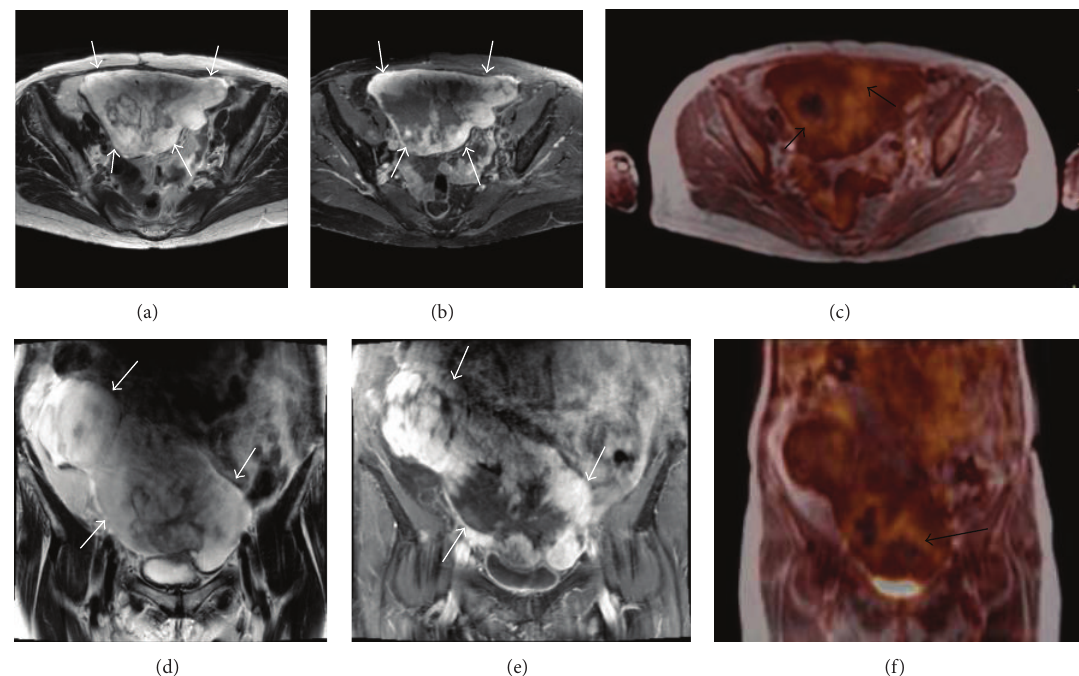
Figure 3: A 68-year-old patient with abdominal liposarcoma. The large tumour (white arrows) is well recognizable on both the T2-weighted images ((a) and (d)) and the contrast-enhanced, fat-saturated T1-weighted images ((b) and (e)). The fused PET/MR images ((c) and (f)) show an inhomogeneous FDG uptake (black